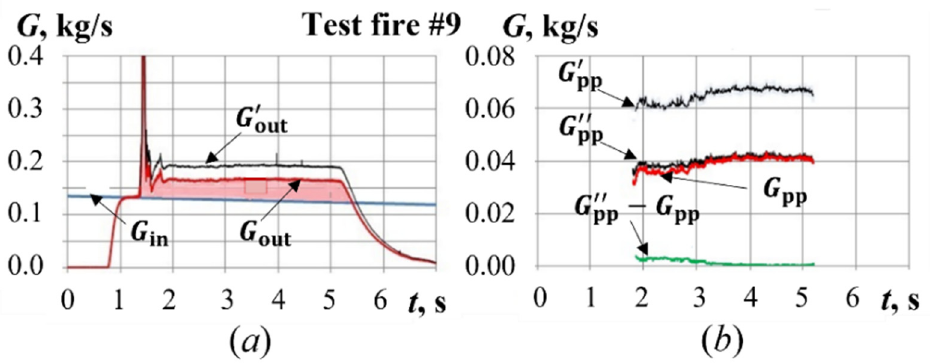
Figure 8. Calculated time histories of total gas mass flow rates ( a ) and mass flow rate of gasification products ( b ) for test fire #9.